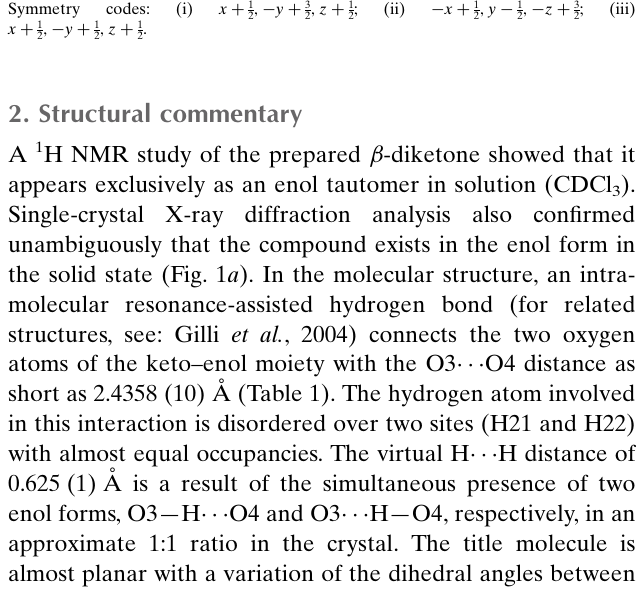
approximate 1:1 ratio in the crystal. The title molecule is almost planar with a variation of the dihedral angles between